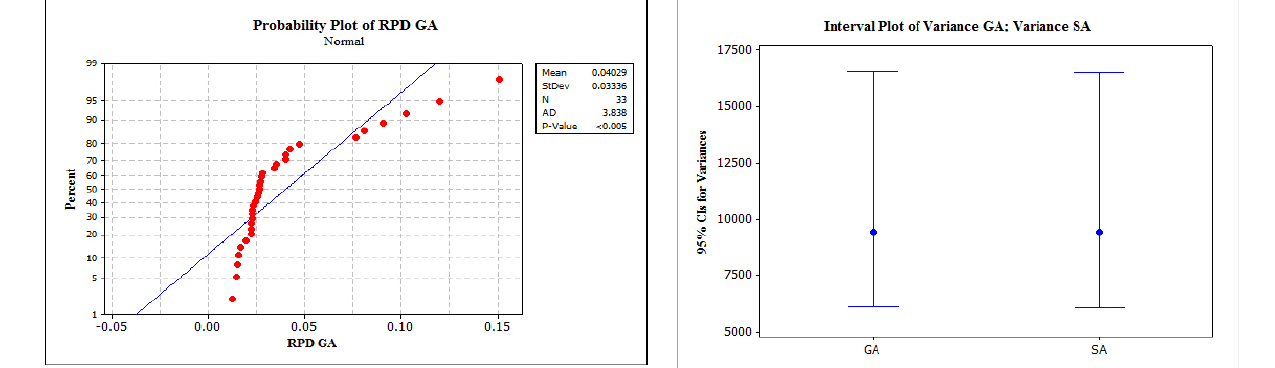
Fig. 4. Normality test for proposed GA RPD (small and large problems)